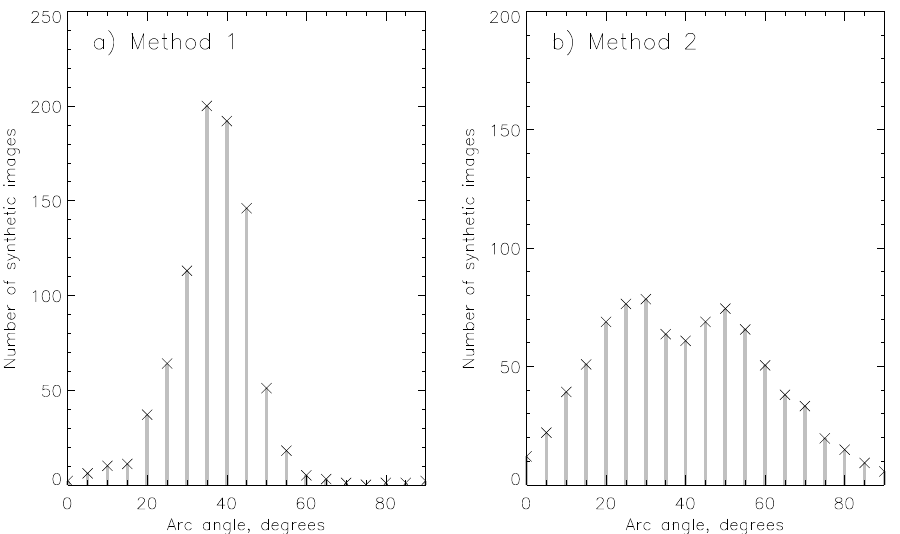
Fig. 9. Histograms showing the distribution of arc angles for images which produce results further than 1 standard deviation from the mean result for (a) method 1 and (b) method 2.